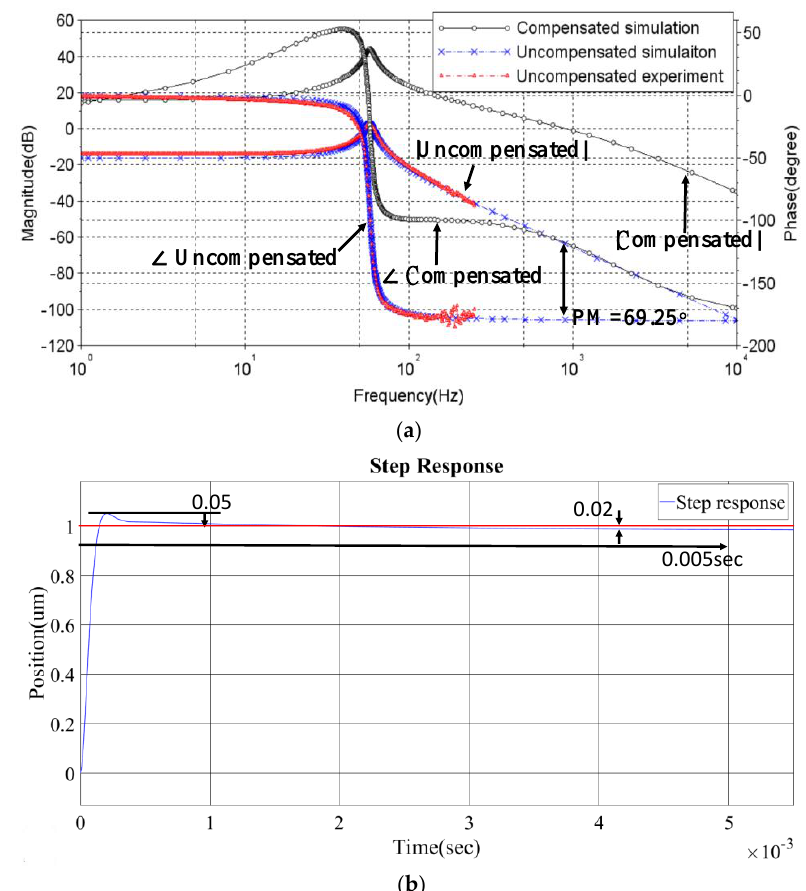
Figure 7. Simulated results with the designed controller applied to the OIS. ( a ) Bode plots for x -direction; ( b ) step response along x -direction.